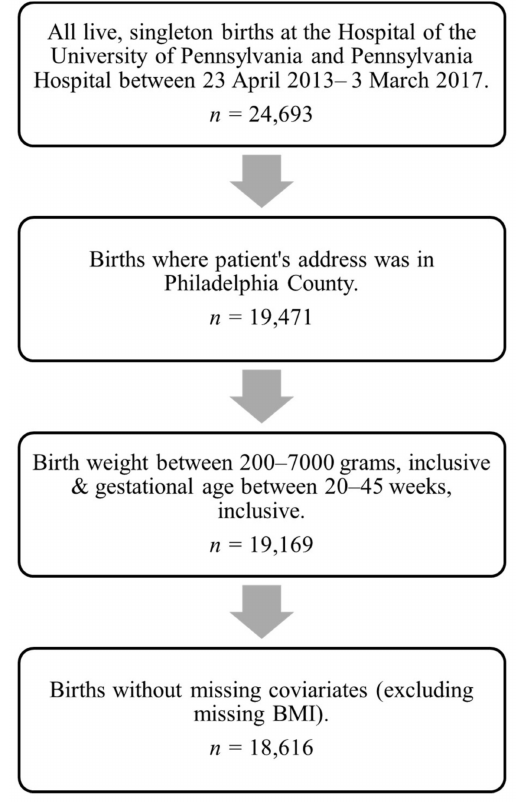
Figure 1. Analytic cohort